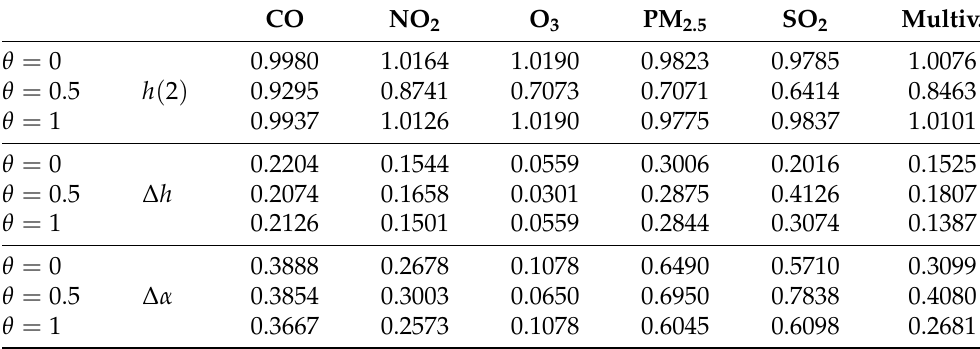
Table 4. The scaling exponent h ( 2 ) , multifractality degrees ∆ h , and ∆ α : raw